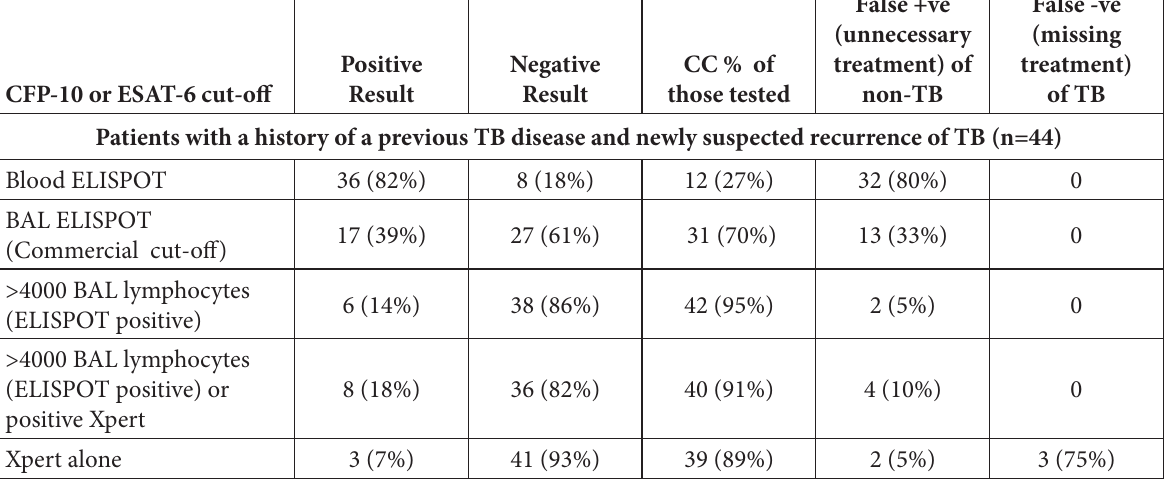
Table 2. Performance of Different Testing and Result Interpretation Strategies.